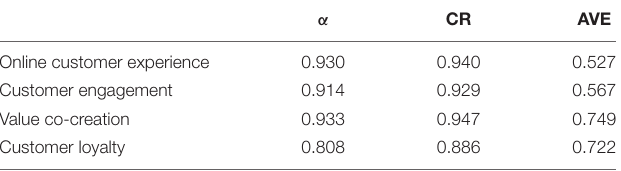
TABLE 2 | Construct reliability and validity.